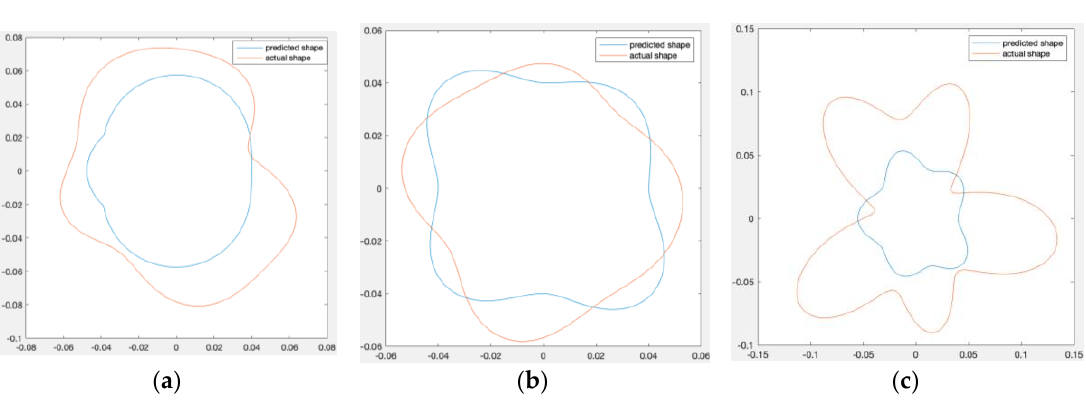
Figure 14. Sections of the processed cylinder on different Z-positions: predicted data (blue) against actual shape (red). Difference in dynamics at the same revolution speed (4000 rpm) and with different shapes and heights of processing. All data are in mm. ( a ) Shape with 3 pulses per revolution, Z = 40 mm ( b ) Shape with 4 pulses per revolution, Z = 80 mm ( c ) Shape with 5 pulses per revolution, Z = 100 mm.